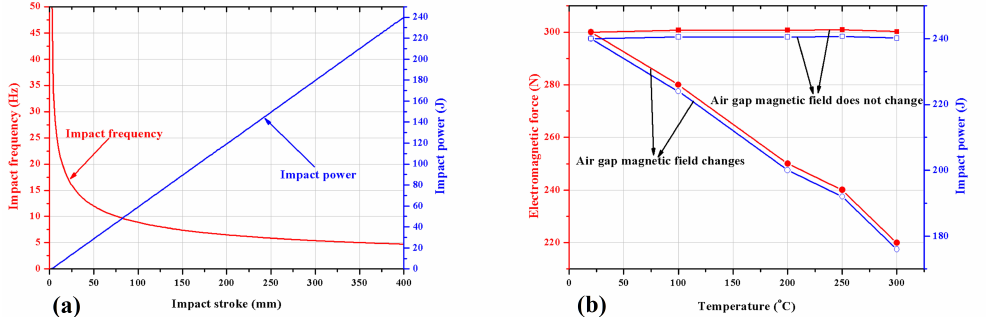
Figure 8. The impact frequency and impact power with different impact strokes ( a ); average electro- magnetic thrust and impact power curves under different temperatures ( b ) (Wu et al.